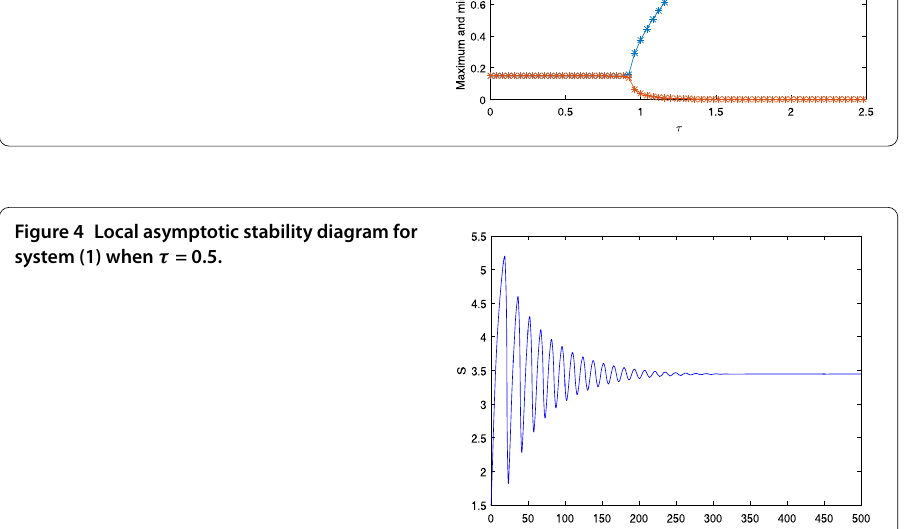
Figure 4 Local asymptotic stability diagram for system (1) when τ =